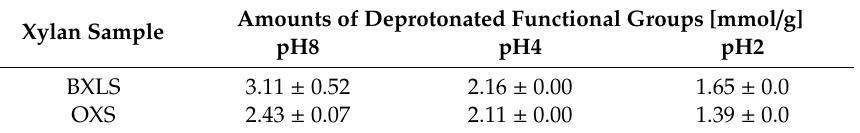
Table 1. Amounts of deprotonated/protonated acidic groups in sulfated xylan samples (BXLS and OXS) at different pH values.